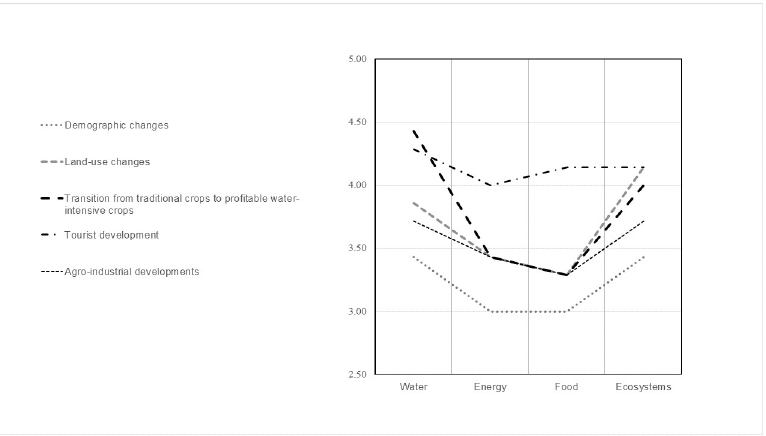
Fig 5. Impact of drivers of change on the WEFE sectors. Mean of the rating on a scale from 1 to 5, where 1 is "very low impact" and 5 is "very high impact". The coefficient of variation was below 0.3 for all ratings.